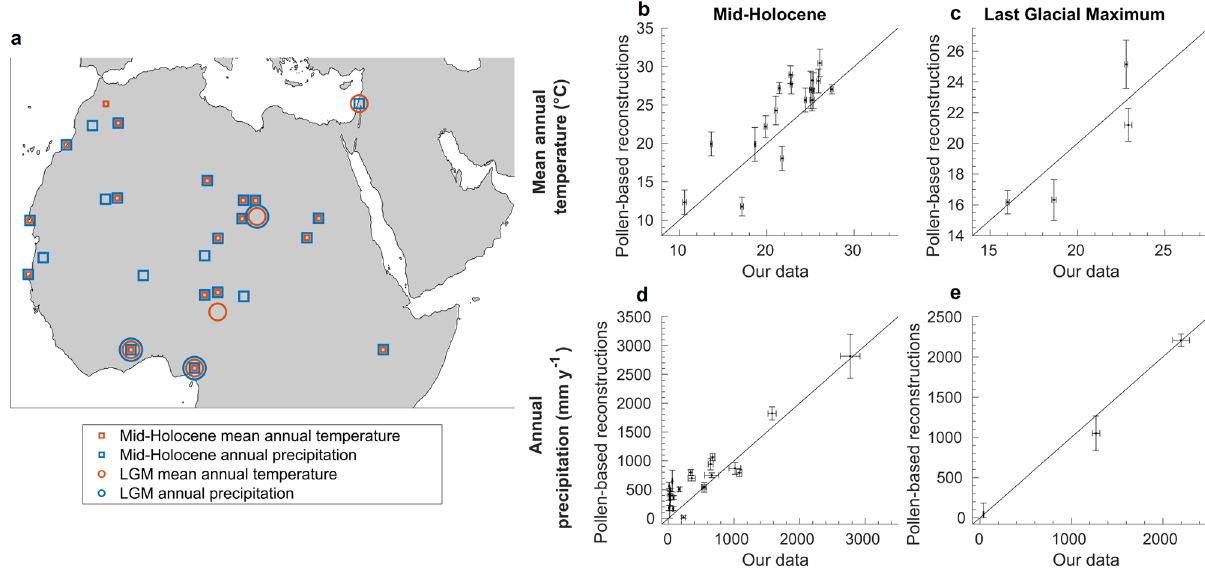
Fig. 5 Comparison of our data to pollen-based climate reconstructions from the mid-Holocene and the last interglacial period. a Geographical locations and timings of pollen records. b – e Comparisons of our data against empirical reconstructions. Vertical centre measures and error bars represent the empirical reconstructed values and their uncertainties, respectively; horizontal centre measures and error bars represent simulated climatological normals at 1k-year intervals (Eqs. (2) and (6)) and the 10th and 90th percentile of the simulated decadal data ( n = 100; Eqs. (4) and (7)), respectively.